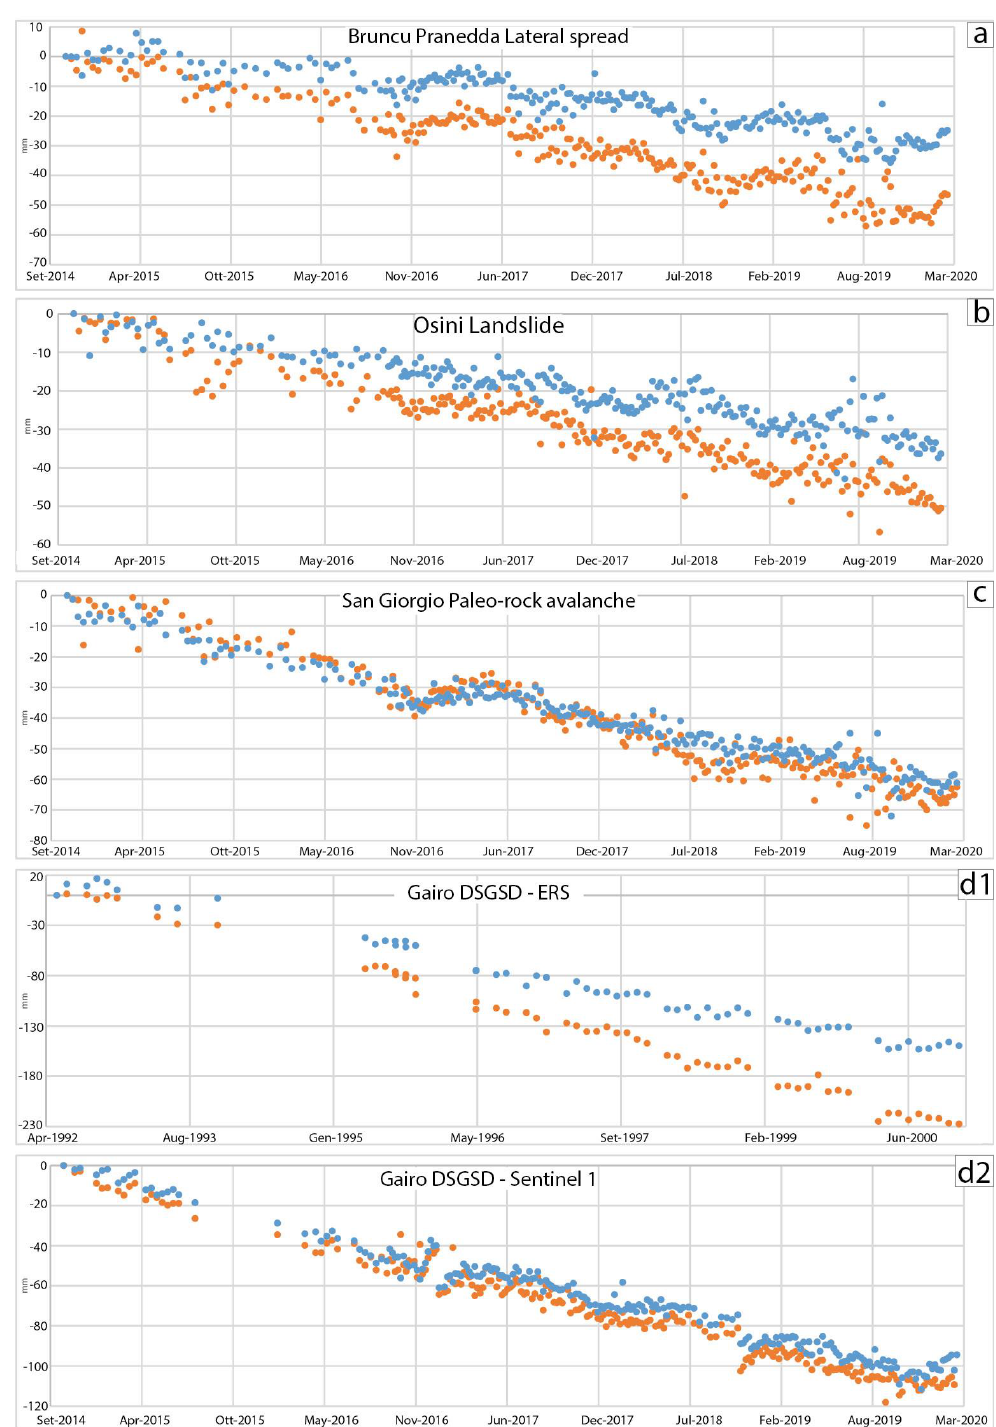
Figure 6. Time series extracted with the representative permanent scatters. The vertical axes represent the cumulative LOS displacement; the horizontal axes represent the time. ( a ) Bruncu Pranedda lateral spread — seasonal displacement trend, maximum displacement of 5 cm from 2014 to 2020; ( b ) Osini landslide — seasonal displacement trend, maximum displacement of 6 cm from 2014 to 2020; ( c ) San Giorgio paleo-rock avalanche — constant movement trend of the large blocks, maximum displacement of 6 cm from 2014 to 2020; ( d ) Gairo DGSD; ( d1 ) the ERS data show a constant deformation trend, with a maximum displacement o f23 cm from 1992 to 2000; ( d2 ) the Sentinel 1 data show a constant deformation trend that is correlated with the ERS data, with a maximum displacement of 10 cm from 2014 to 2020. The colors of the points agree with the colors of the stars that identifies the location of the PS in Figure 5.